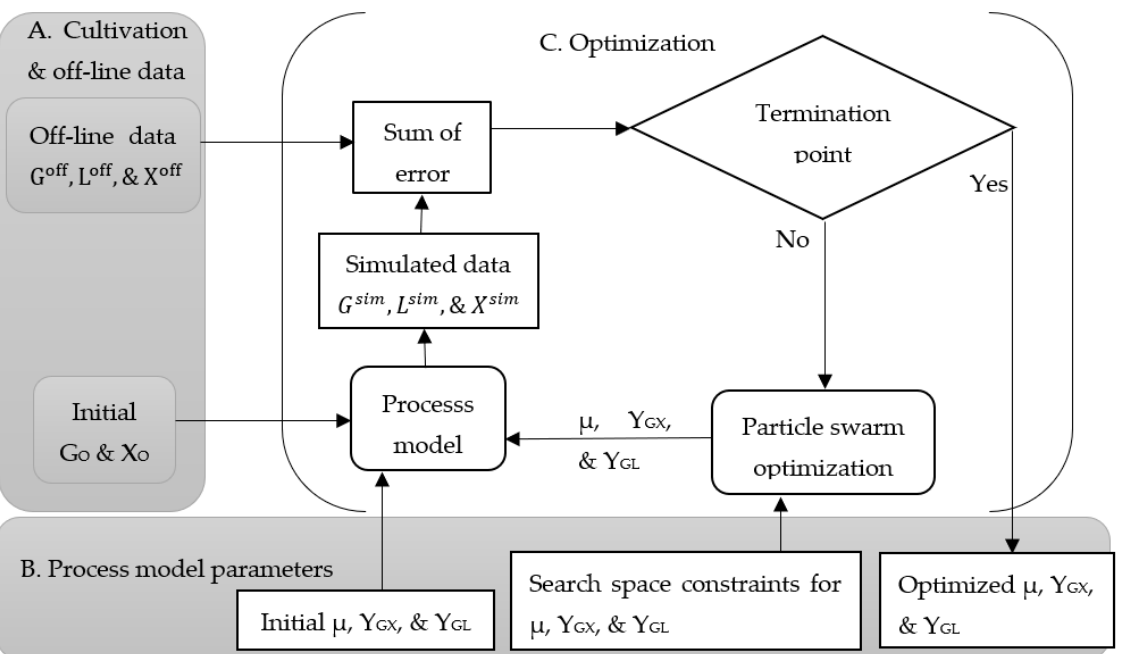
Figure 1. Classical approach for the optimization of the process model parameters for the cultivation of Lactiplantibacillus plantarum A6 and Lacticaseibacillus rhamnosus GG; G O and X O are the initial concentrations of glucose and biomass, respectively; G off , L off , and X off are the offline data for glucose, lactic acid, and biomass, respectively; G sim , L sim , and X sim are the simulated data for glucose, lactic acid, and biomass, respectively; µ , microbial specific growth rate; Y GX , yield coefficient with respect to the conversion from glucose to biomass; and Y GL , yield coefficient with respect to the conversion from glucose to lactic acid. ( A ) displays the offline data acquired during cultivation, ( B ) shows the initial and optimized process model parameters, and ( C ) illustrates the optimization process.